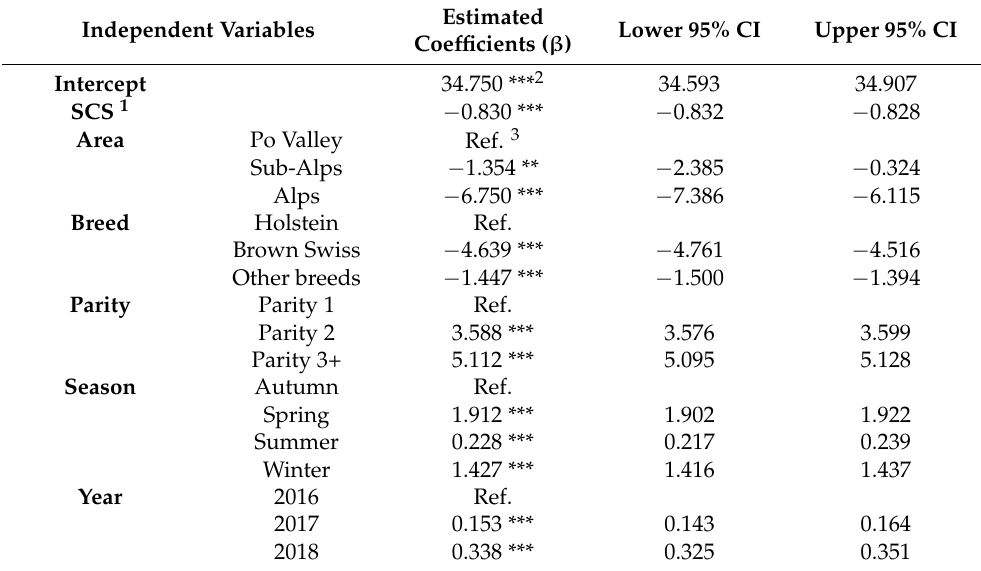
Table 2. Coefficient estimates ( β ) of the linear mixed model for milk production (in kg/day). The estimates for Days in Milk are not